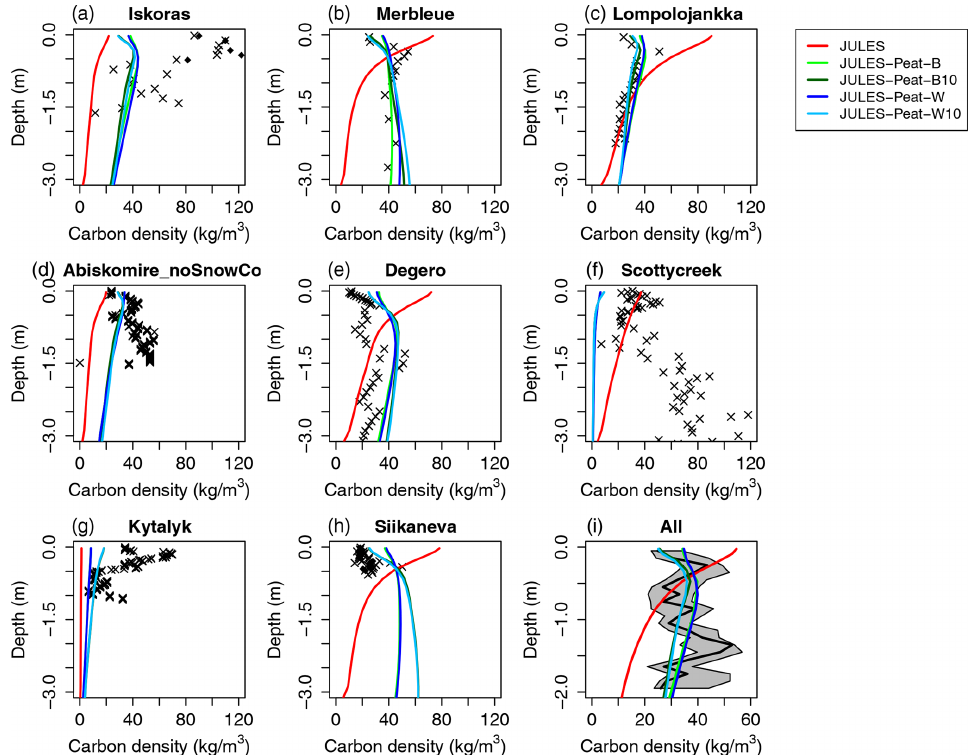
Figure 4. Evaluation at organic sites. Observations are shown with black crosses or lines. The black line in (i) is the median of all sites, with the grey area indicating the interquartile range. Note that the axis ranges are different in (i) . In JULES-Peat-W and JULES-PeatW10 (dark blue and light blue lines, respectively) the lateral water flow is set to zero. The simulations with “10” on the end have τ lit = 10. For information about the sites refer to Table 1, and for details of the JULES simulations refer to Table 2.